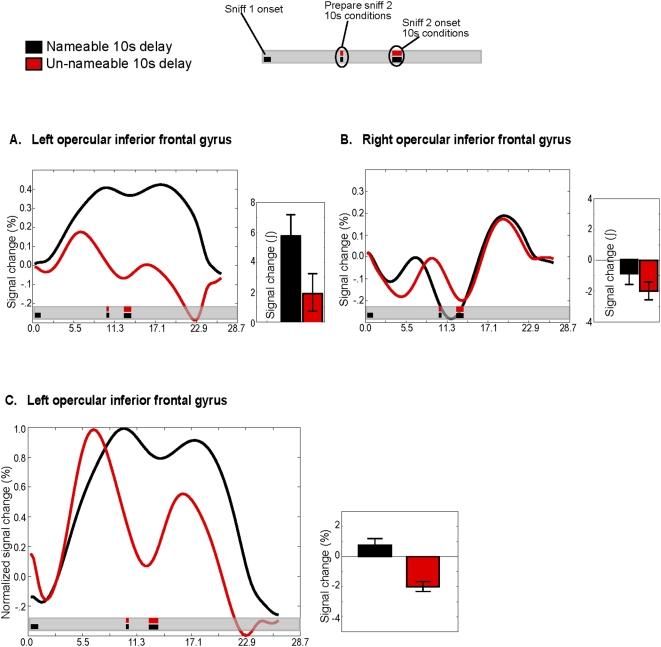
Activity in inferior frontal gyrus.A. The deconvolved time course of activity in left inferior frontal gyrus area. Although we analyzed data from opercular, orbital and triangular inferior frontal gyri, all data shown in the figure are from the opercular region. The smaller panels show the binned response of the 10-second delay nameable and unnameable odorant conditions. Bar graphs depict the integral under the curve in response to sniff-one of the delayed match to sample task. Error bars represent the standard error. Smelling nameable odorants elicited more activity than unnameable odorants. B. The deconvolved time course of activity in right inferior frontal gyrus area is shown as in A. On the right side, there was no difference between conditions. C. Memory-related activity in left inferior frontal gyrus. Shown is the time course of activity that has been analyzed identically to the data shown in figure 3. The level of activity during the delay period was greater when subjects were remembering nameable odorants as compared to unnameable odorants.